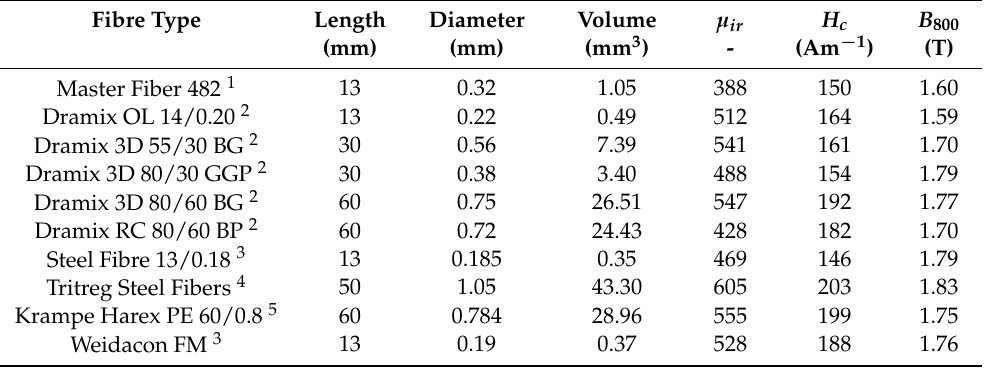
Table 1. Overview of the used fibres and their selected parameters. H c is the magnetic coercivity and B 800 is the magnetic flux density inside the fibre for field strength of 800 Am − 1 . Commercial names written in the Fibre Type column, manufacturers information in the table’s footnotes.